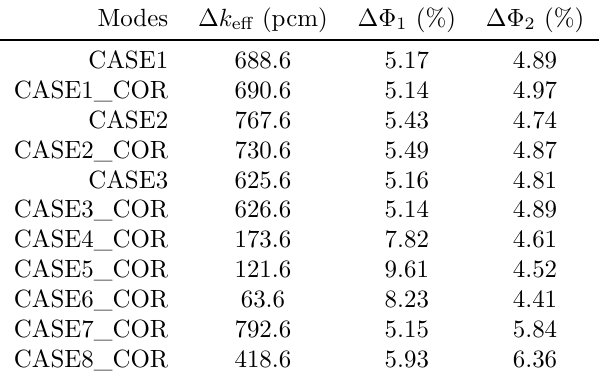
Table 3. Two group results of the test case with fuel